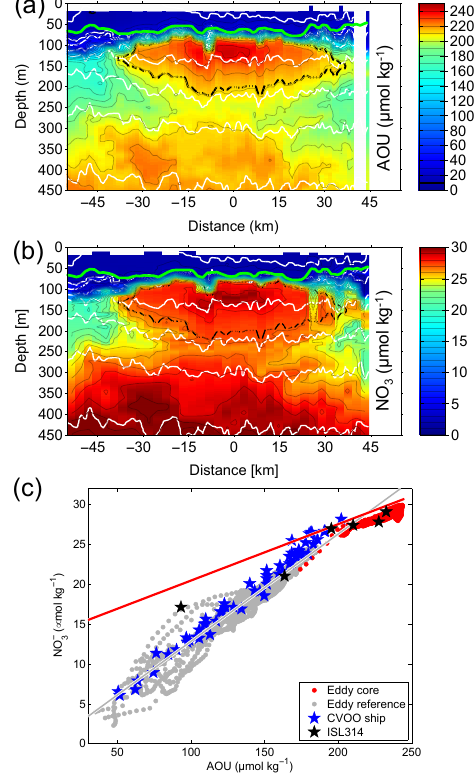
Figure 7. (a) AOU and (b) NO − from glider IFM13 survey. 3 (c) AOU versus NO − for the depth range 90 to 250m depth – 3 (red dots) glider IFM13 survey in the low oxygen core, (black dots) IFM13 glider survey close to CVOO, (blue stars) CVOO ship data, and (black star) the Islandia ISL_00314 eddy survey (see Fielder et al., 2016, for details on the surveys). The linear best fit to the glider data outside the eddy (grey line; slope 8.77) and inside the core (red line; slope 0.56) are